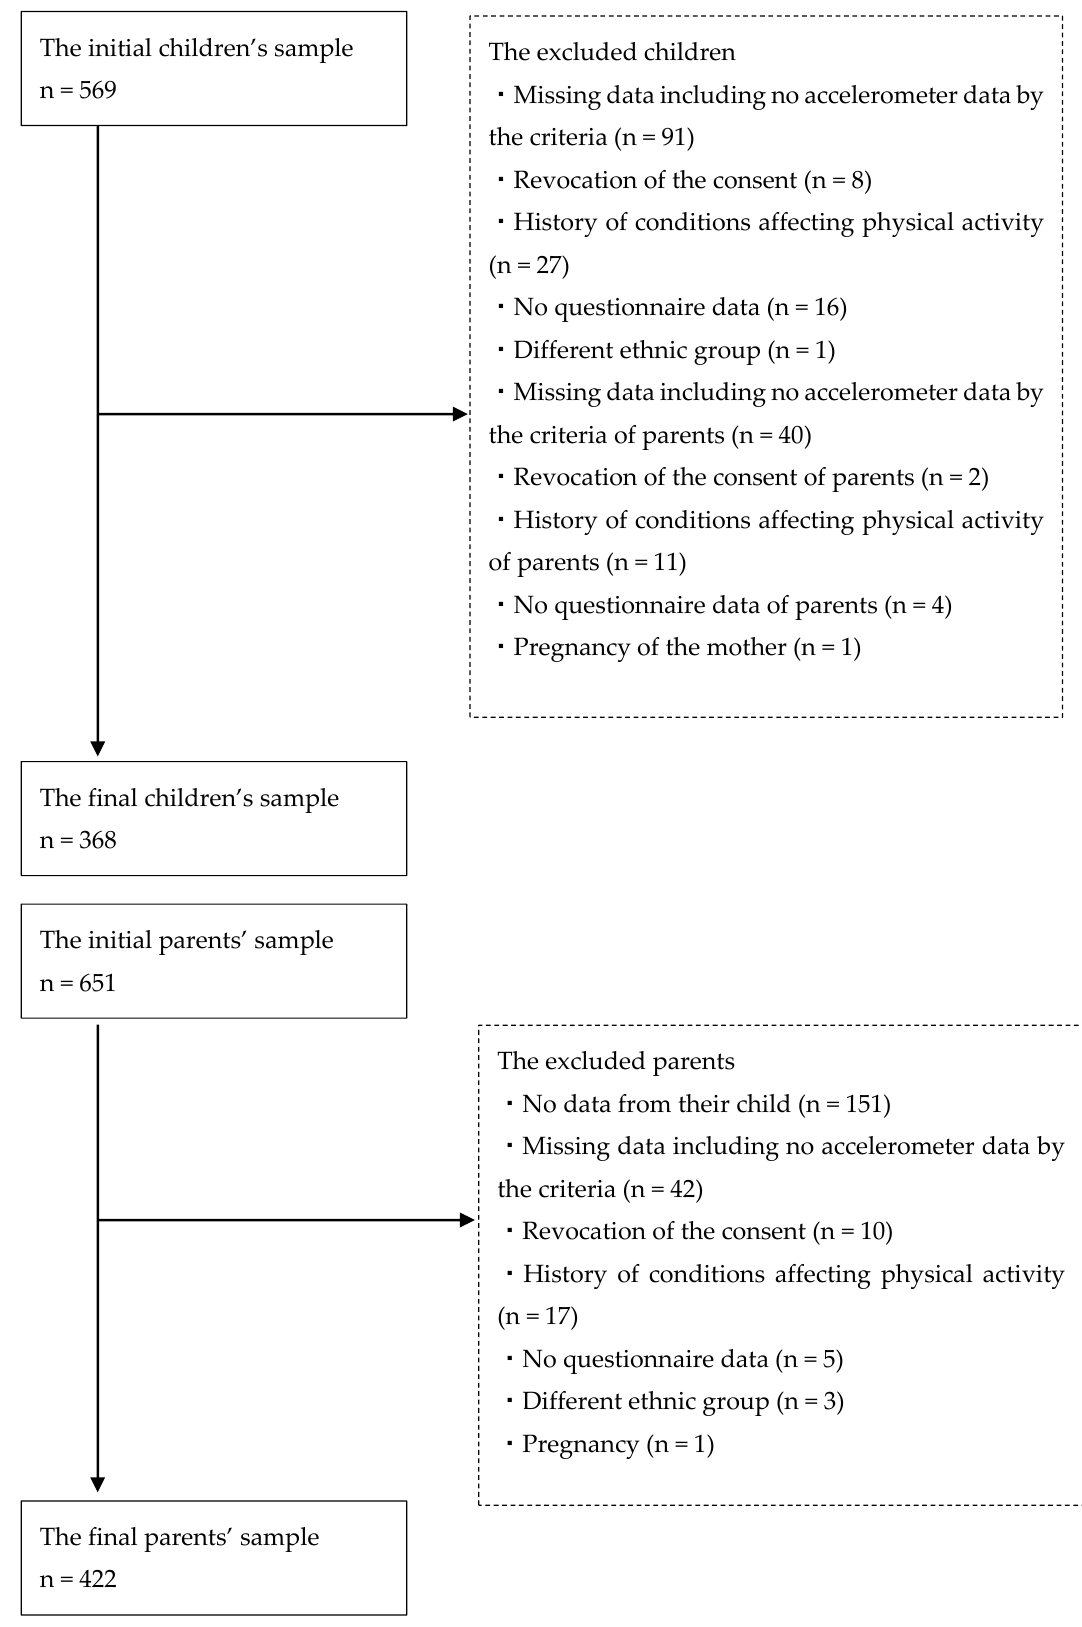
Figure 1. Flow of Figure 1. Flow of participants.